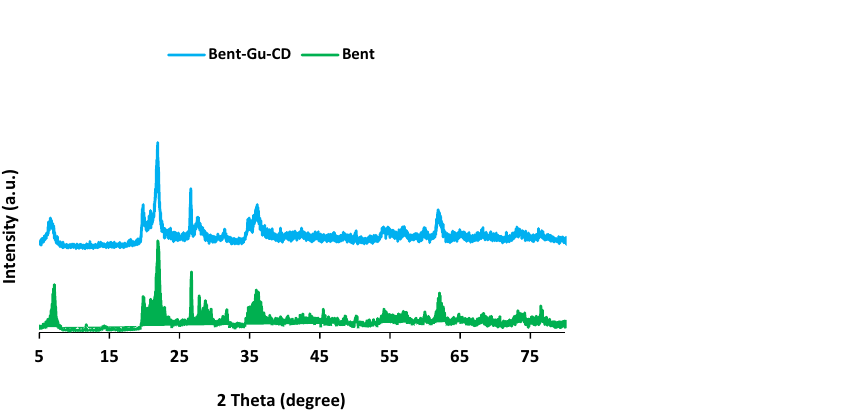
Figure 3. FTIR spectra of Bent, Bent-IS, Bent-IS-Gu and Bent-Gu-CD.